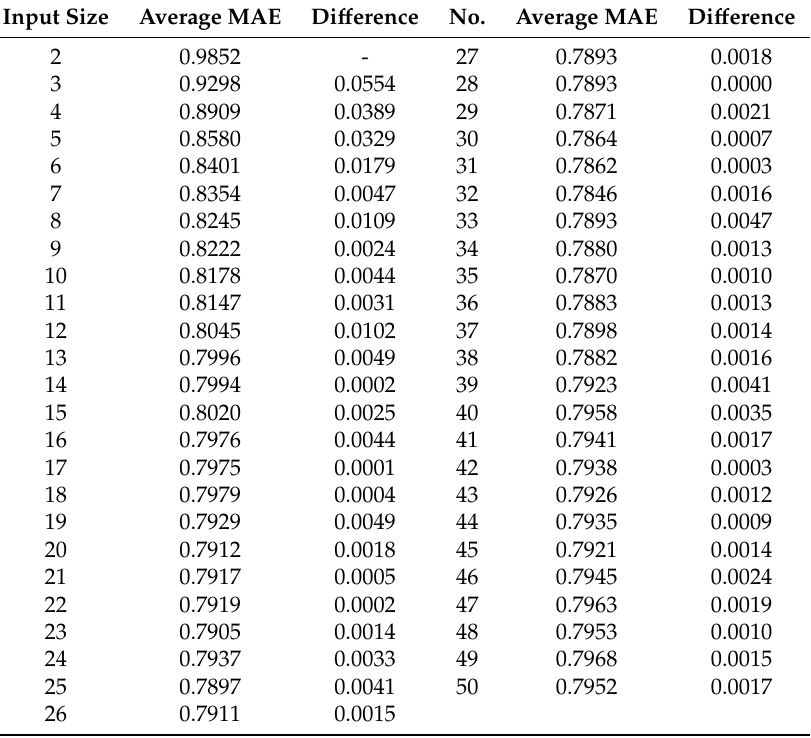
the Pearson correlation coe ffi cient). Input Size Average MAE Di ff erence